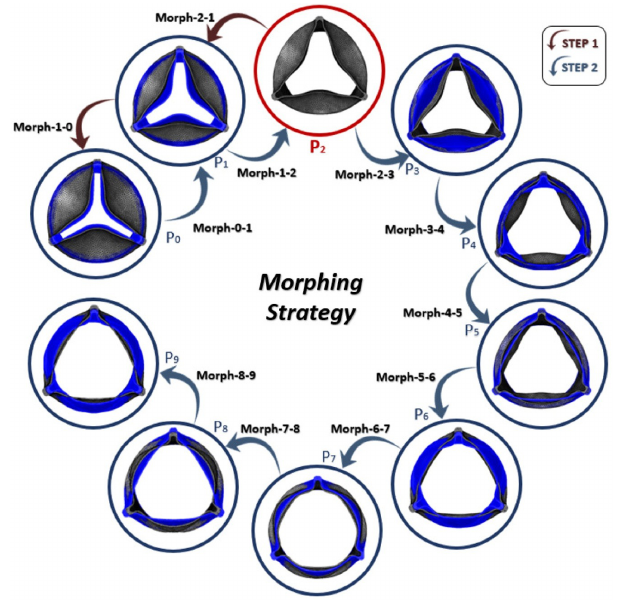
Figure 7. Workflow of the FSI analysis with imposed wall motion